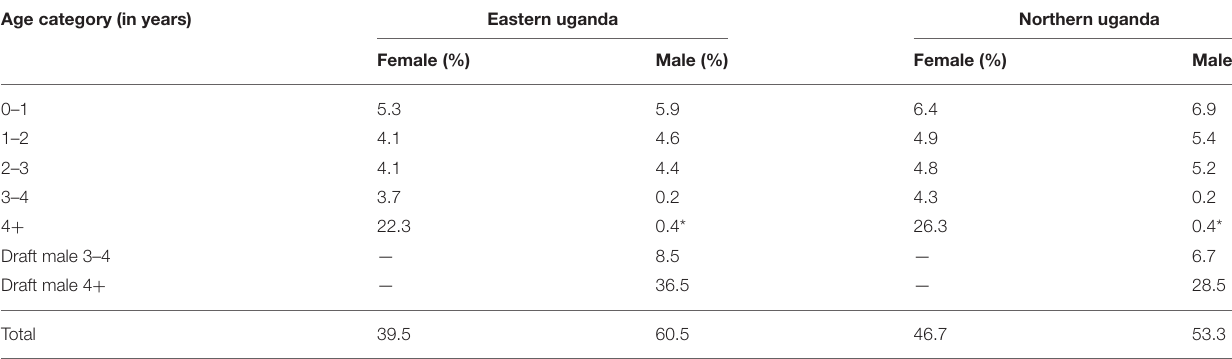
TABLE 4 | Projected cattle herd composition for the 6-year period. Age category (in